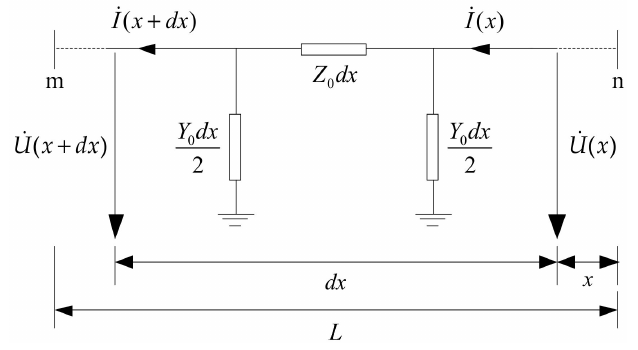
Figure 4. Distributed parameter